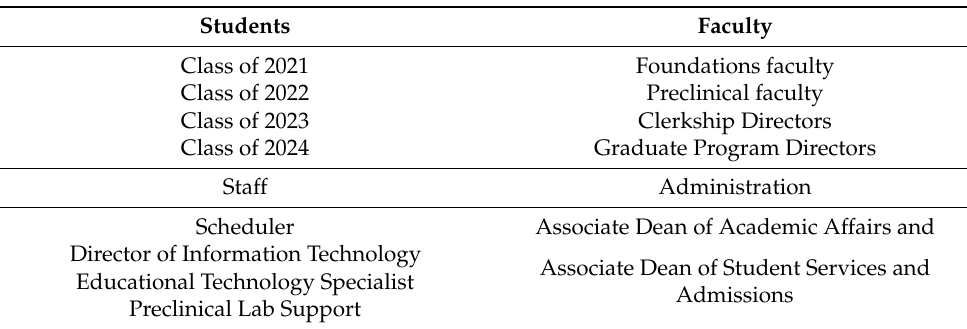
Table 1. Focus group interviews. Standardized questions were asked for the student, foundations faculty, preclinical faculty, Clerkship Directors, and Associate Dean interviews. Questions specific to expertise were asked for staff and Graduate Program Directors